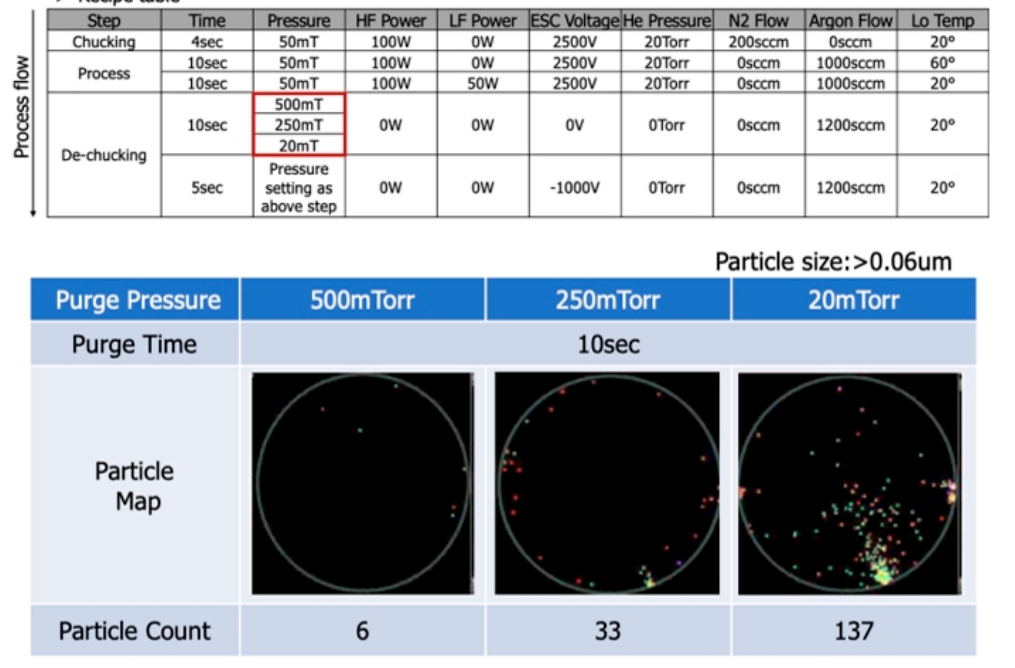
Figure 21. Particle distribution results under different gas purge discharge pressures.